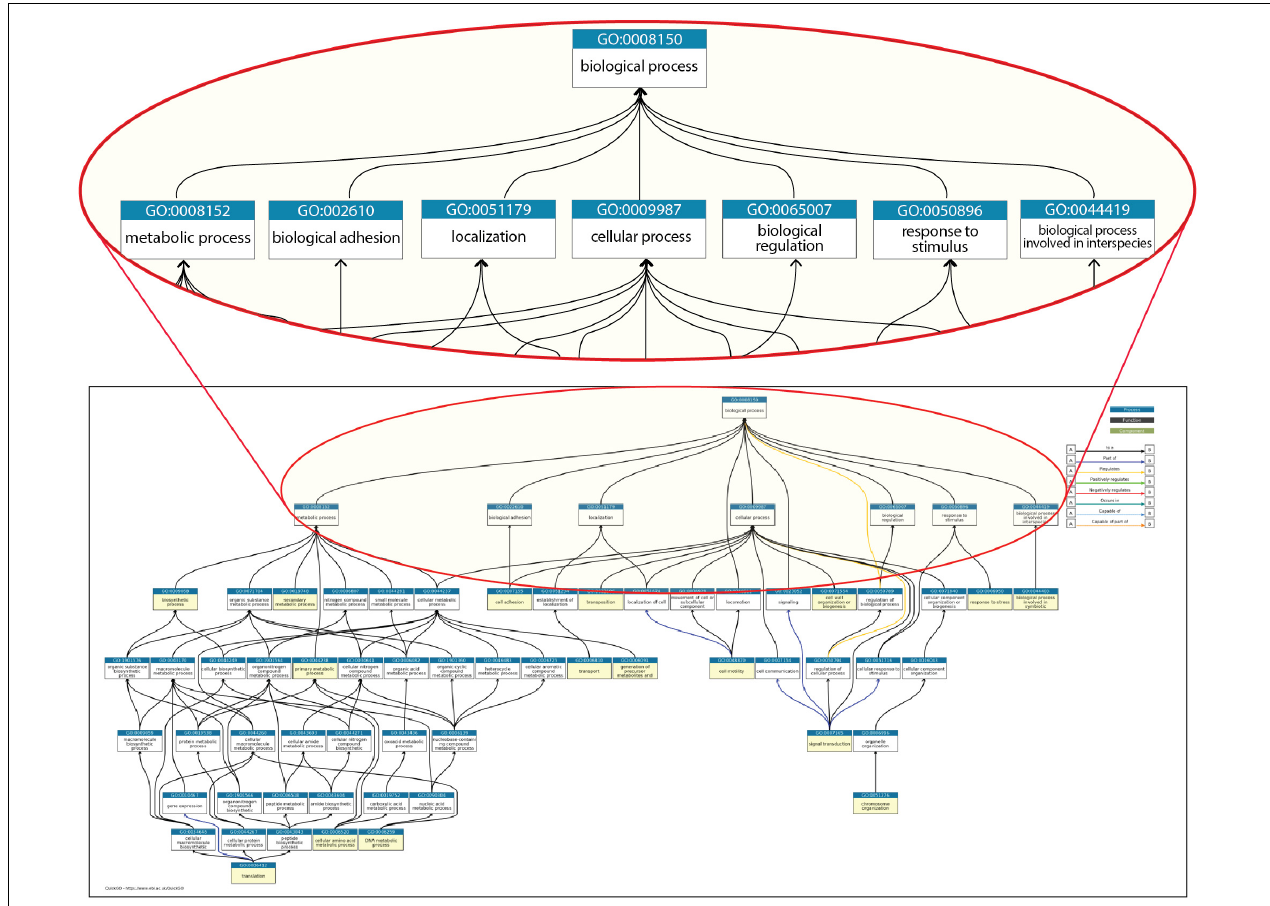
FIGURE 1 | A portion of the structure for “biological processes” within Gene Ontology. All terms shown are required to describe properties of genes from E. coli K-12, with an expanded view of the top-level categories. The whole set of categories for E. coli K-12 genes can be found at